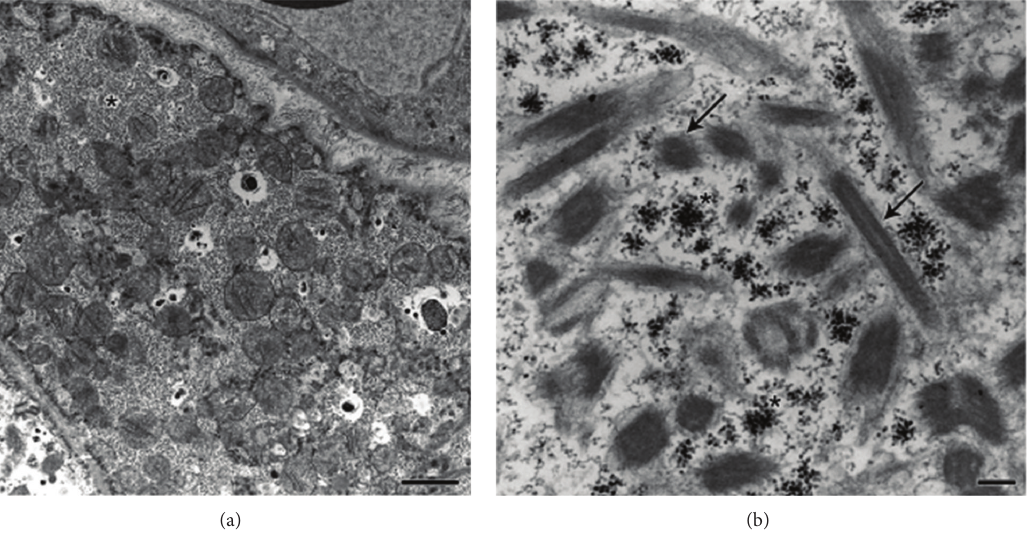
Figure 3: Transmission electron micrograph of rhabdomyoma. Numerous mitochondria and glycogen inclusions (asterisk) are seen (a) among the myofibrils (arrows) (b). Bars: A = 2,5 𝜇 m; B = 1 𝜇